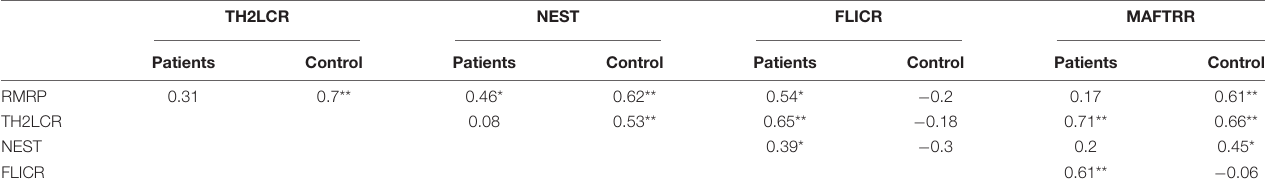
TABLE 4 | Spearman’s correlations between transcript levels among the patients with ASD ( N = 30) and healthy controls ( N = 41).